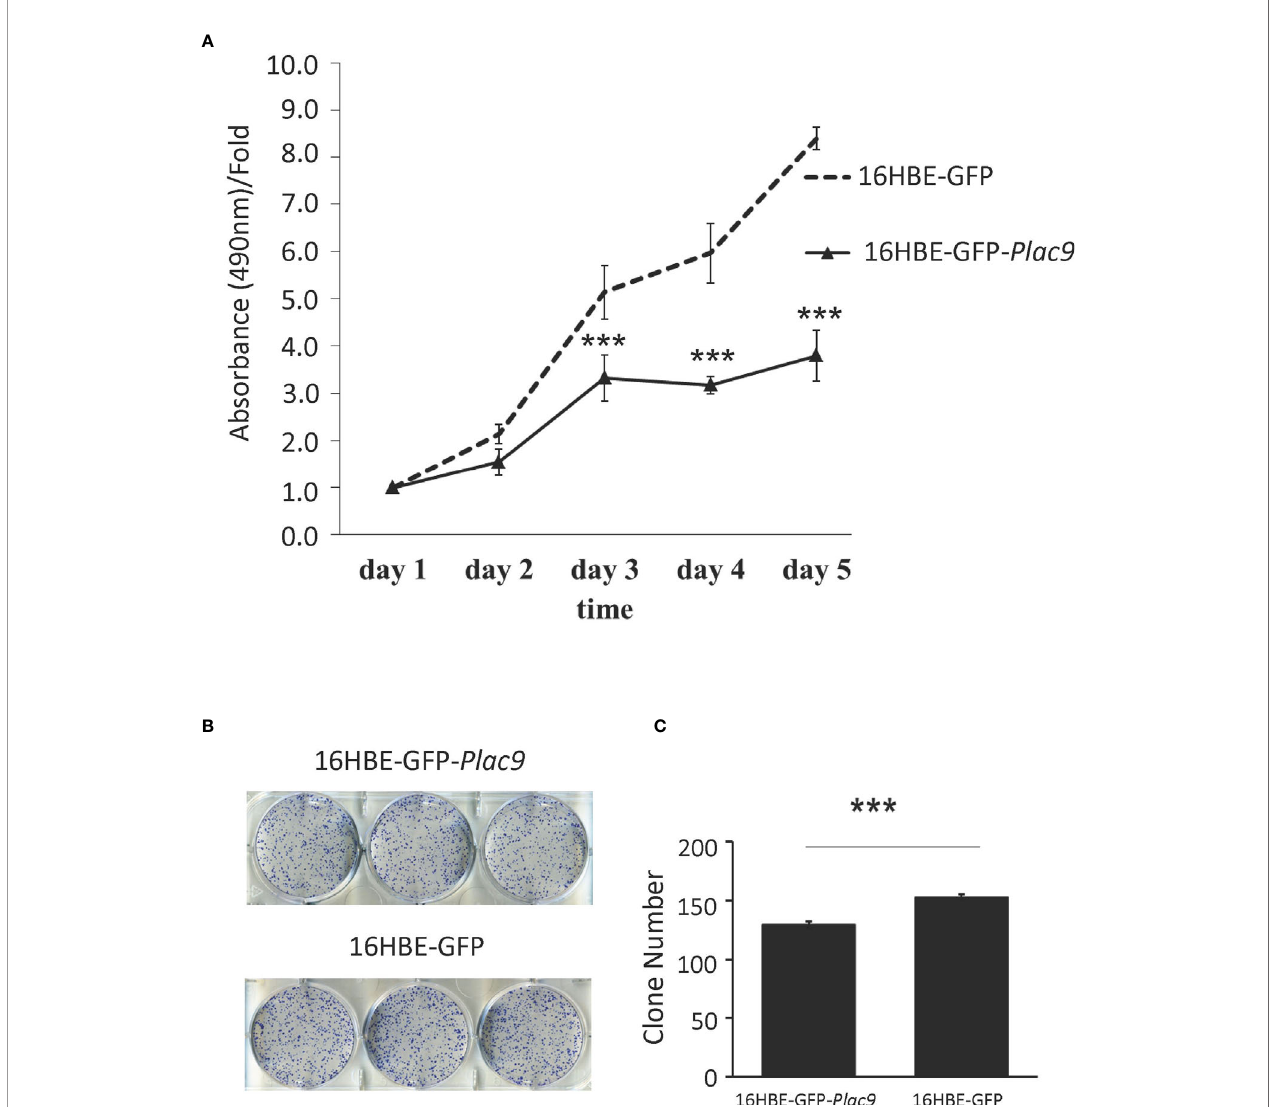
FIGURE 6 | Overexpression of PLAC9 inhibits cellular proliferation and colony formation. (A) Overexpression of PLAC9 inhibits cell proliferation. 16HBE-GFP- Plac9 and the control line 16HBE-GFP were cultured, and cell number was determined daily for 5 days, by measuring the absorbance of the cell culture at 490 nm with the value at staring point (day 1) set to 1. (B, C) Overexpression of PLAC9 inhibits colony formation. 16HBE-GFP- Plac9 and the control line 16HBE-GFP were cultured for 2 weeks to assay for colony formation (B) and the number of colonies/plate were quanti fi ed (C) . (*** p <